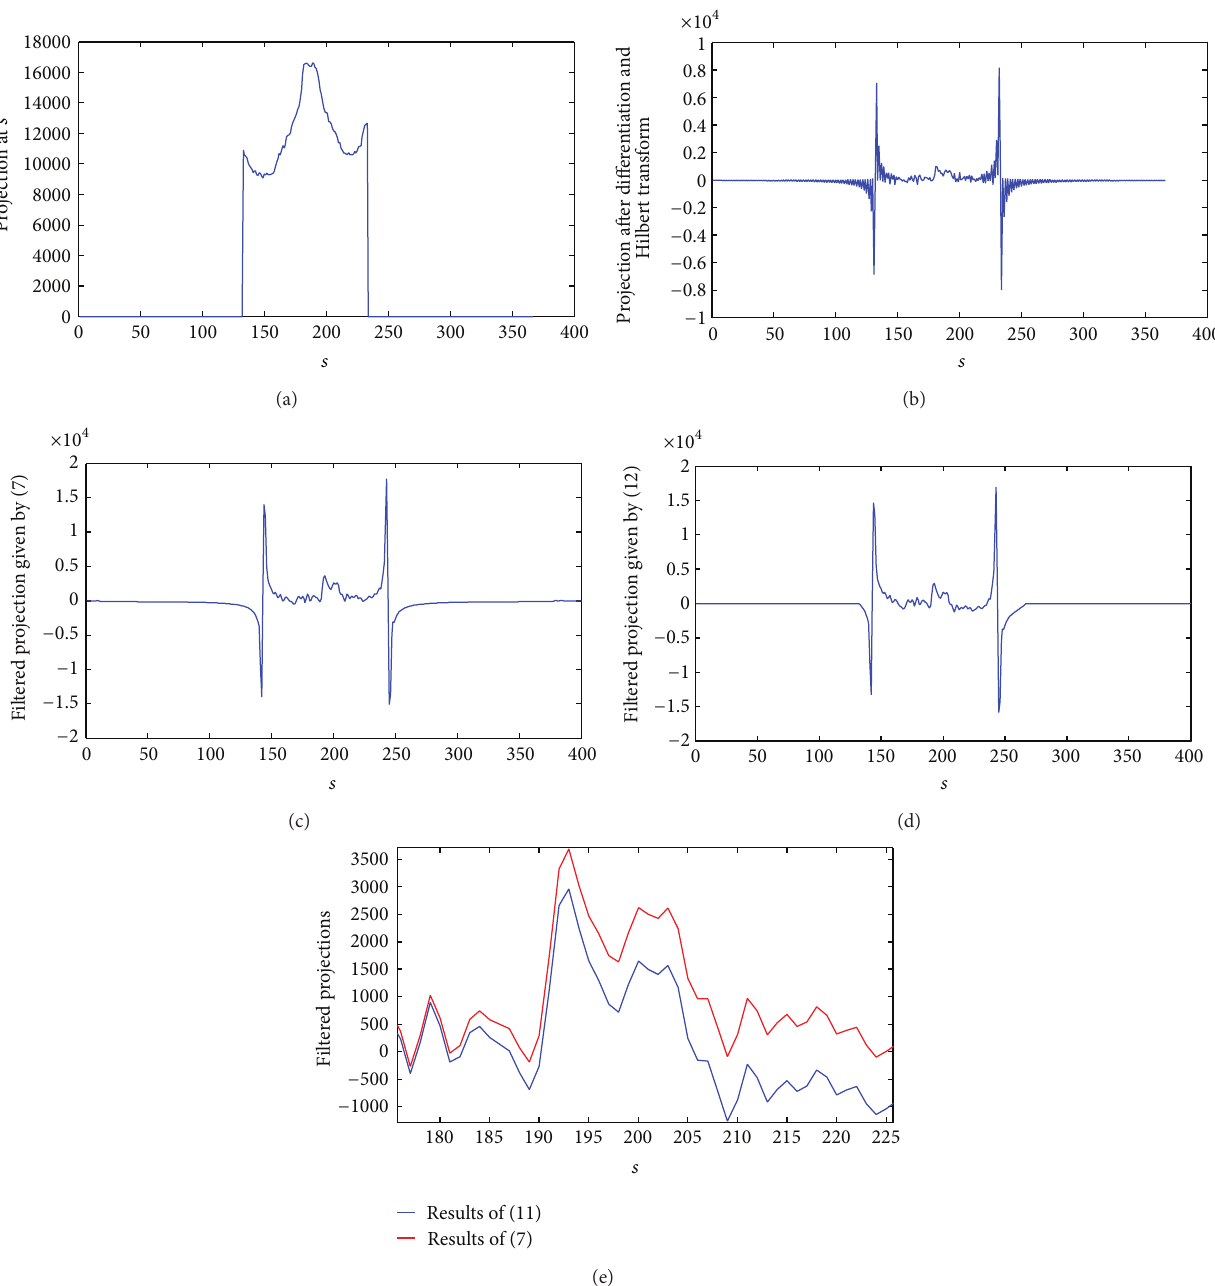
Figure 4: The projection of the Shepp-Logan head phantom at 𝜃 = 0 was truncated and filtered by different methods. The original length of the projection is 367, but only 100 of them were preserved and the rest were set to zero. In this figure, the horizontal axis represented the index of projection line, the vertical axis represented the projection value before and after filtering. (a) Truncated projection at 𝜃 = 0 . (b) Projection after differentiation and Hilbert transform. (c) Filtered projection given by (7). (d) Filtered projection given by (11). (e) Comparison of the filtered projections. Only a part of projections was shown in this